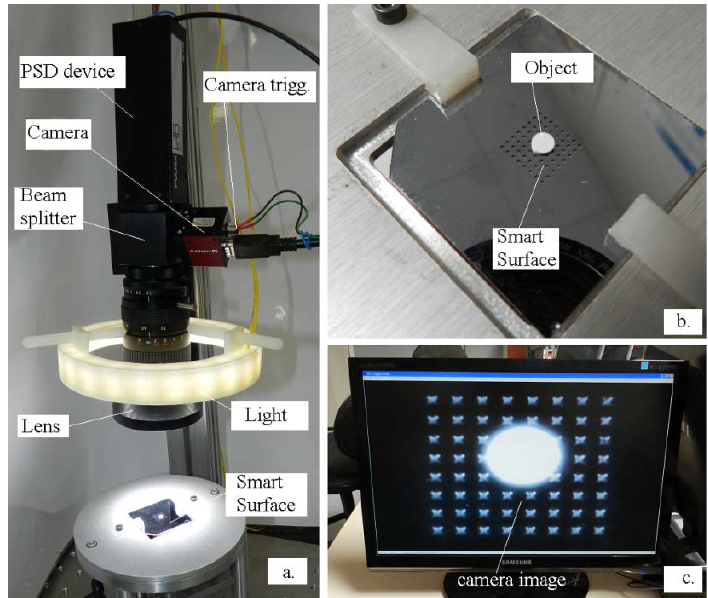
Figure 7. Smart-Surface and sensory system. ( a ) General system view. ( b ) Zoom of the Smart-Surface. ( c ) Camera